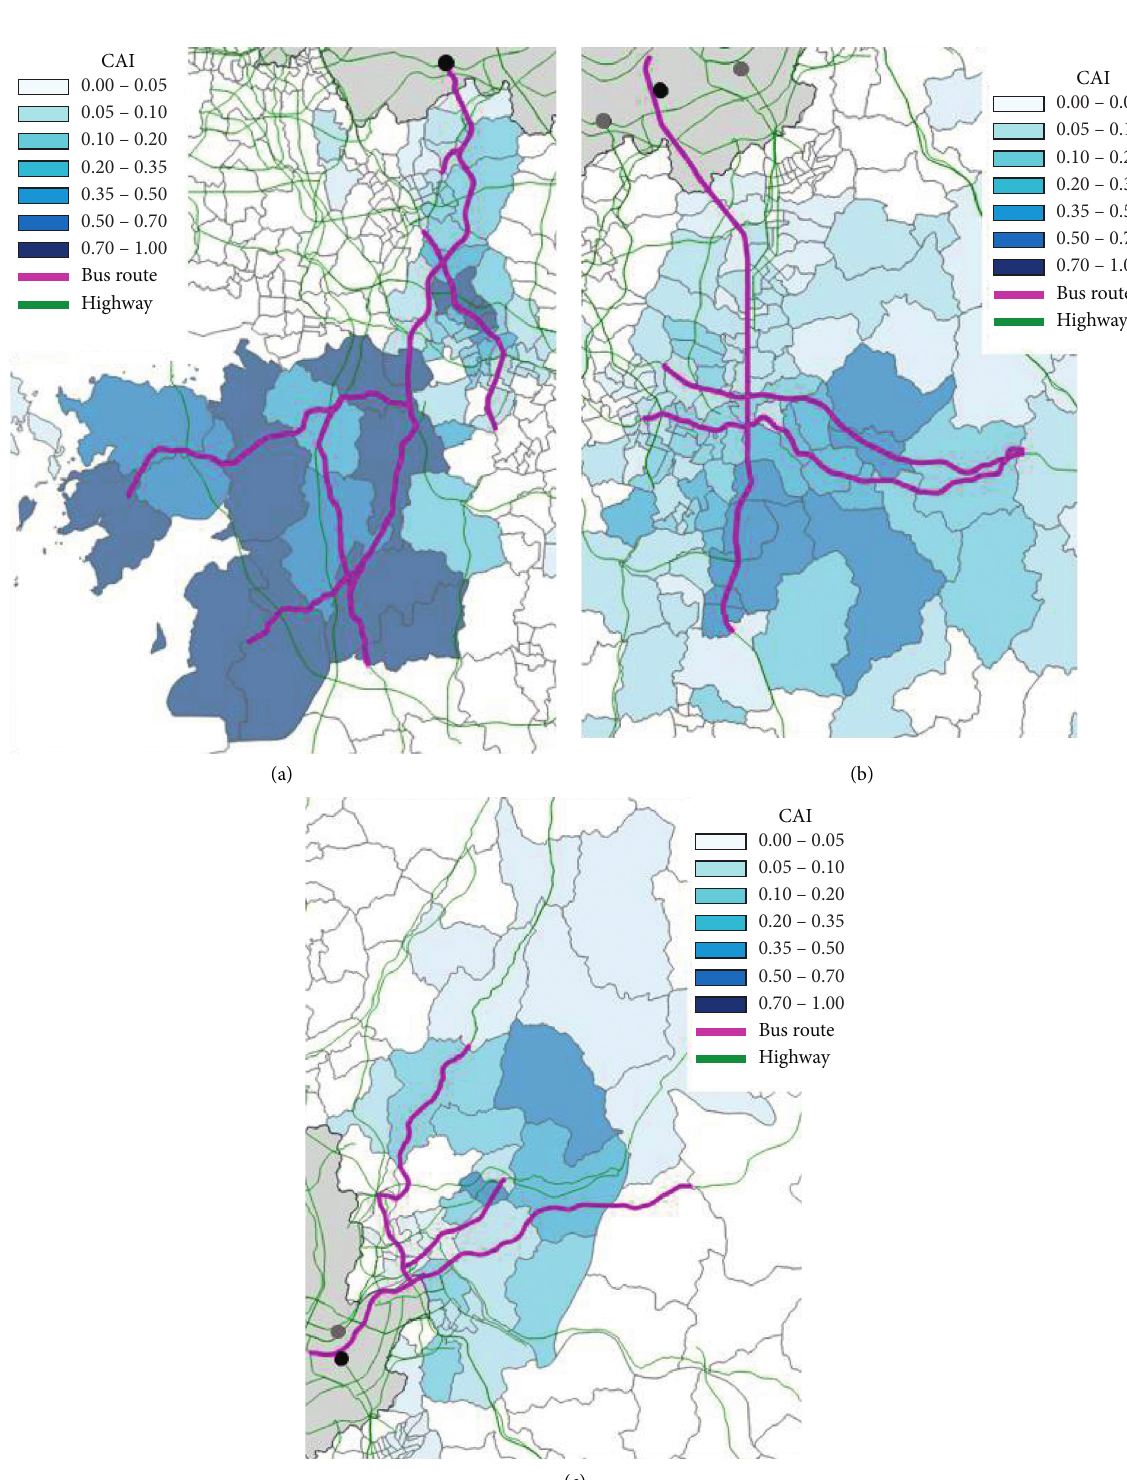
Figure 6: A result of CAI with regional transportation (bus routes and highway): (a) Sadang; (b) Gangnam; (c)